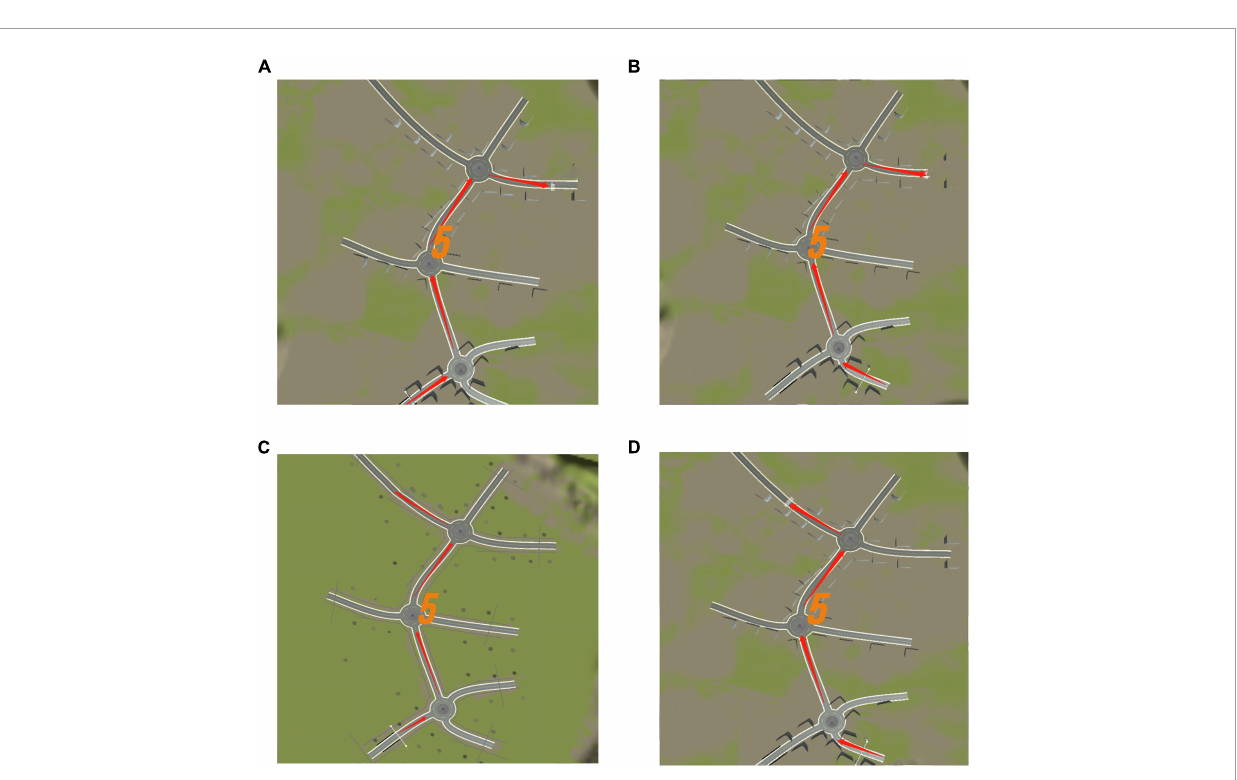
Neck Surgery, Peking University First Hospital, between December 2021 and June 2022. Each patient had a history of dizziness